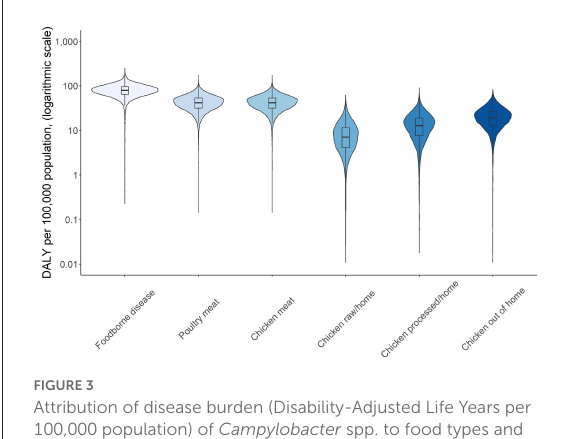
FIGURE3 Attribution of disease burden (Disability-Adjusted Life Years per 100,000 population) of Campylobacter spp. to food types and food products in Burkina Faso in 2017. See Figure 1 for explanation of violin